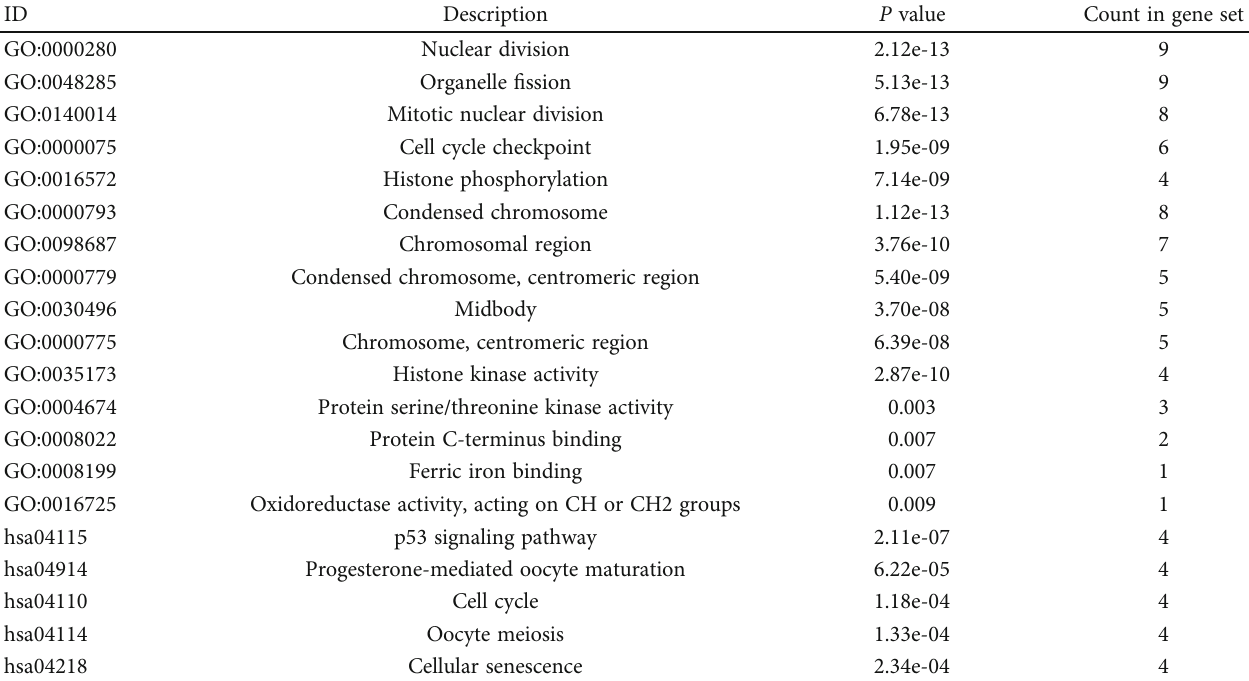
Table 2: GO and KEGG pathway enrichment analyses of DEGs in the most signi fi cant